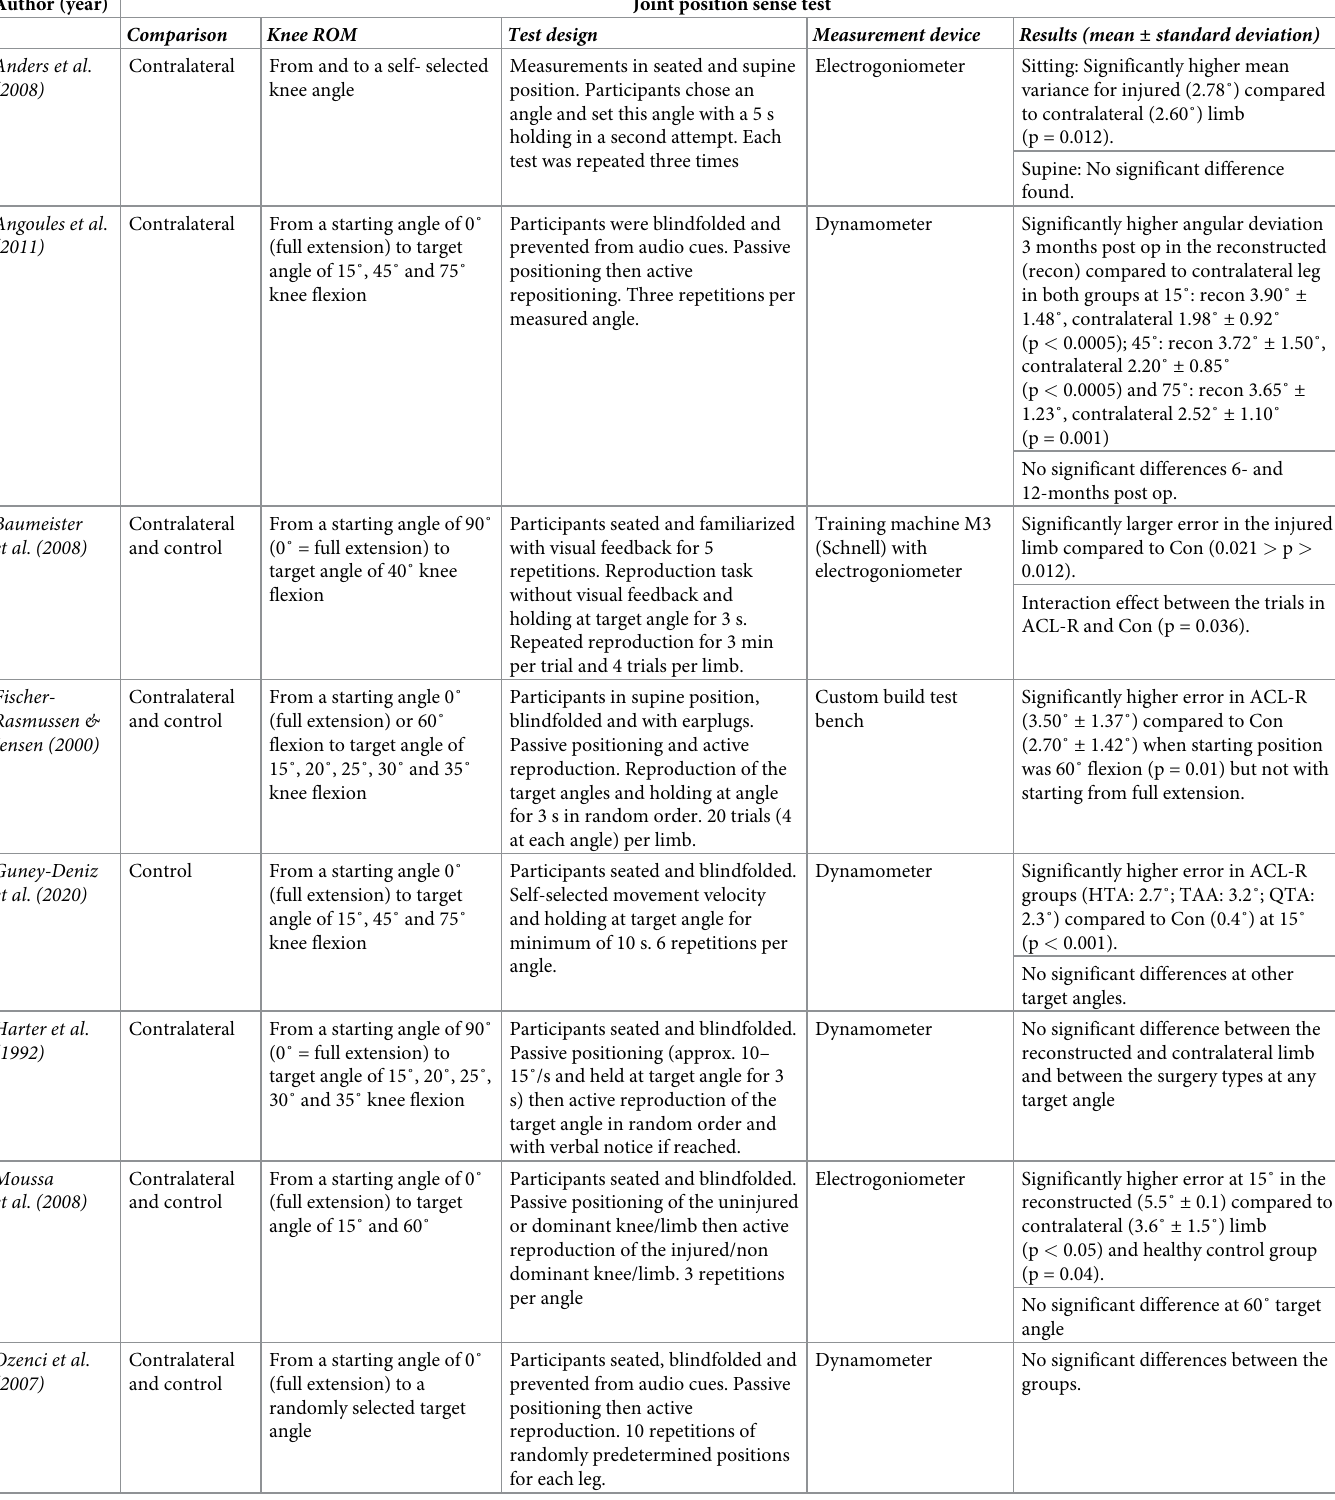
Table 2. Study design and results of the included